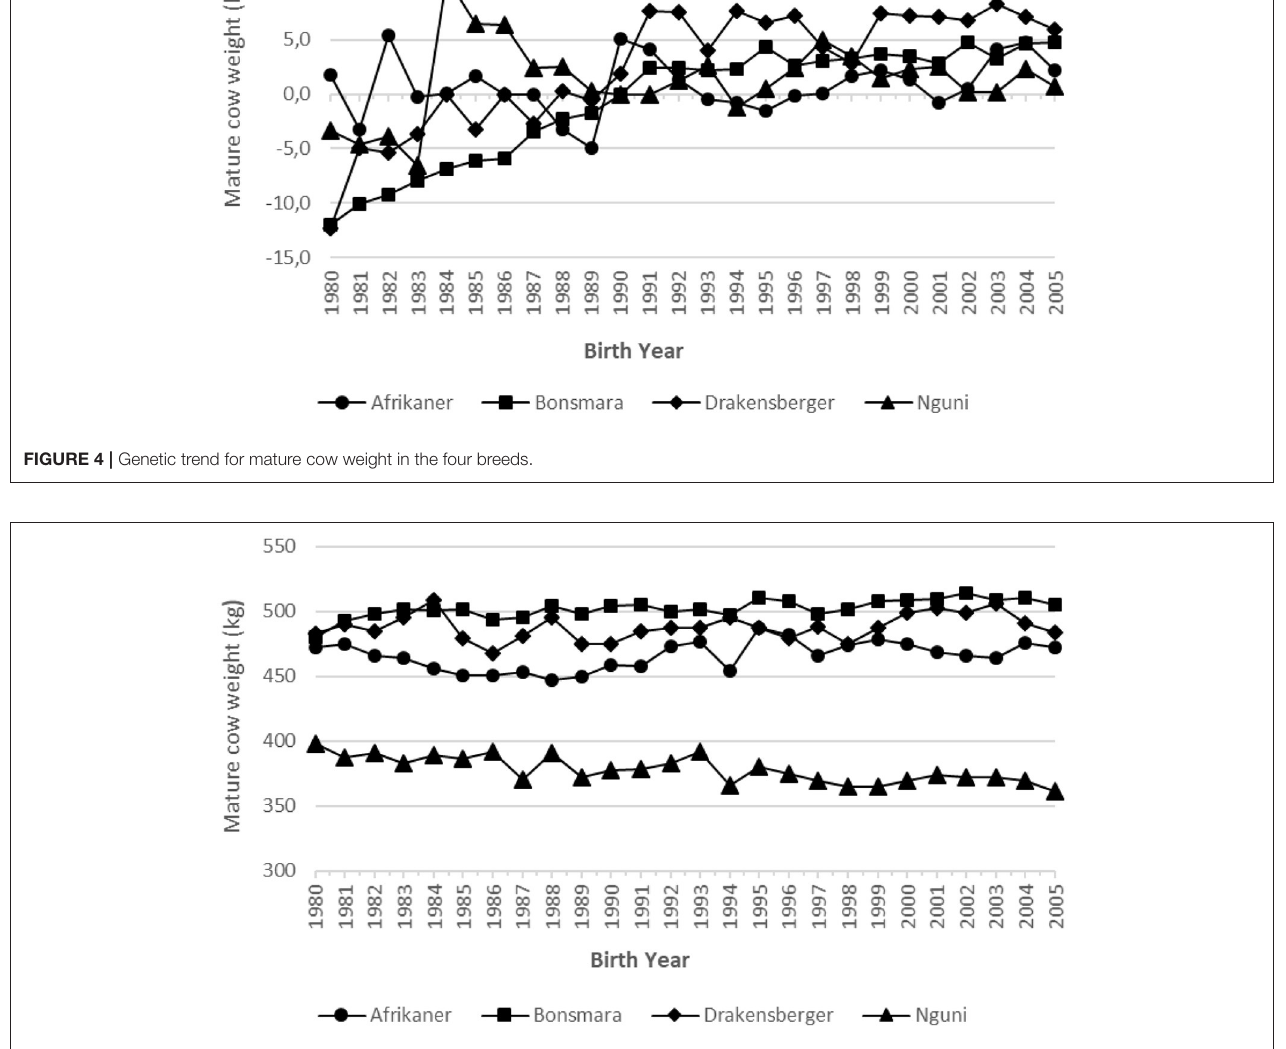
FIGURE 5 | Phenotypic trend for mature cow weight in the four